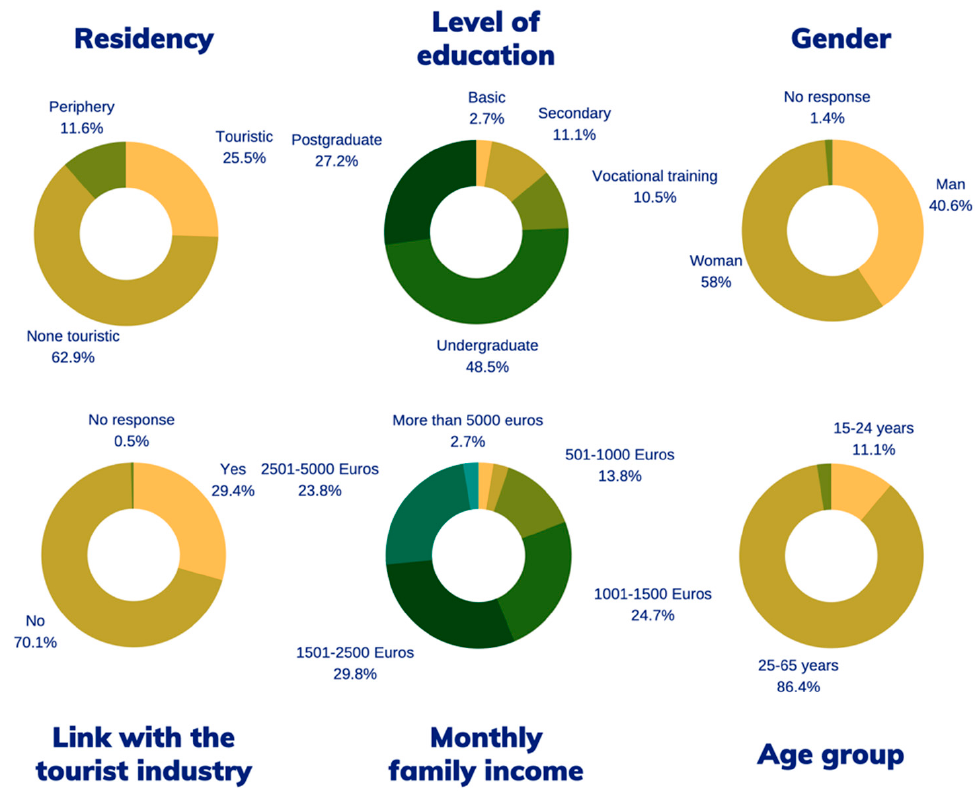
Figure 2. Demographic profile of the survey respondents. Source: own elaboration.